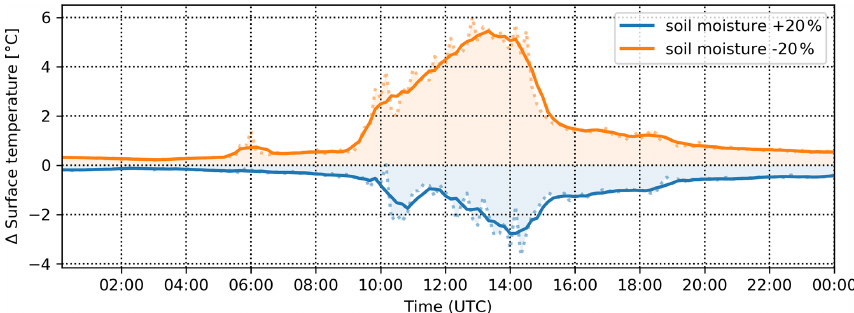
Figure 8. Soil moisture sensitivity of surface temperature difference for scenario SA20 (blue line) and SA21 (orange line) at point F03. Dotted lines: 10min values; solid lines: 1h moving